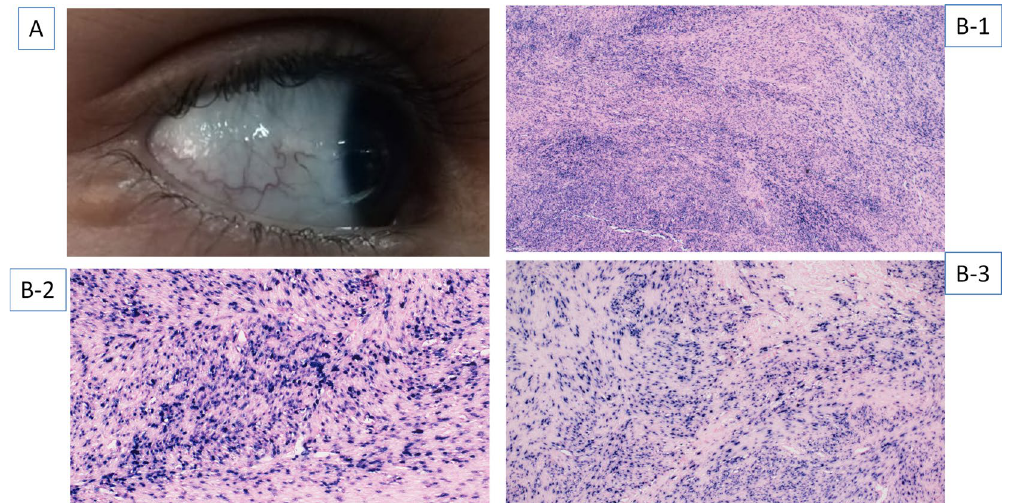
Figure 1. ( A ) Ocular Telangiectasia in the P-15 with Hyper IgM-like phenotype. ( B1 – B3 ) Analysis of EBV- induced smooth muscle tumor in P-16 by Epstein–Barr encoding region (EBER) in situ hybridization